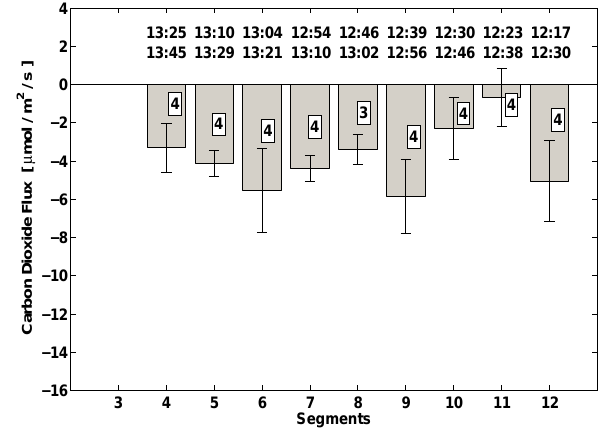
Fig. 10. Same as Fig. 9, except during IOP2 (7–14 September) at